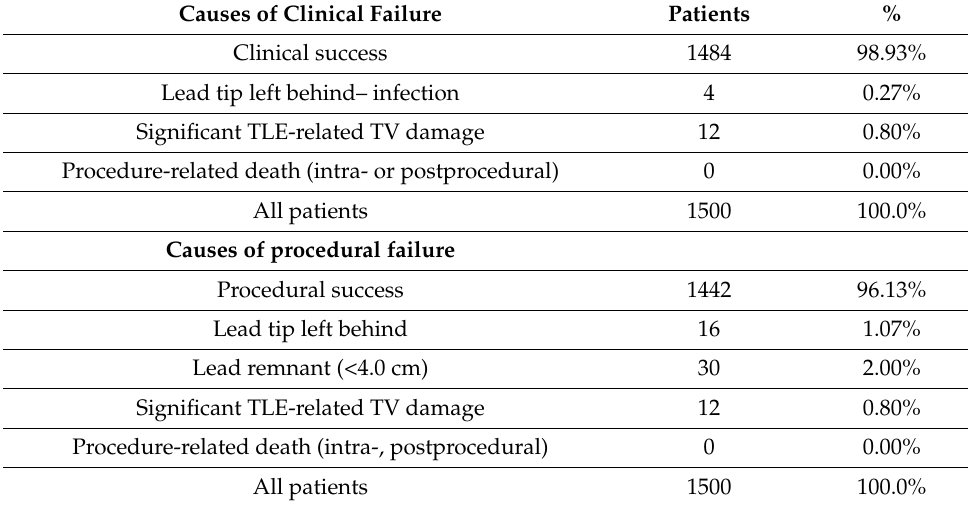
Table 2. Effectiveness and safety of